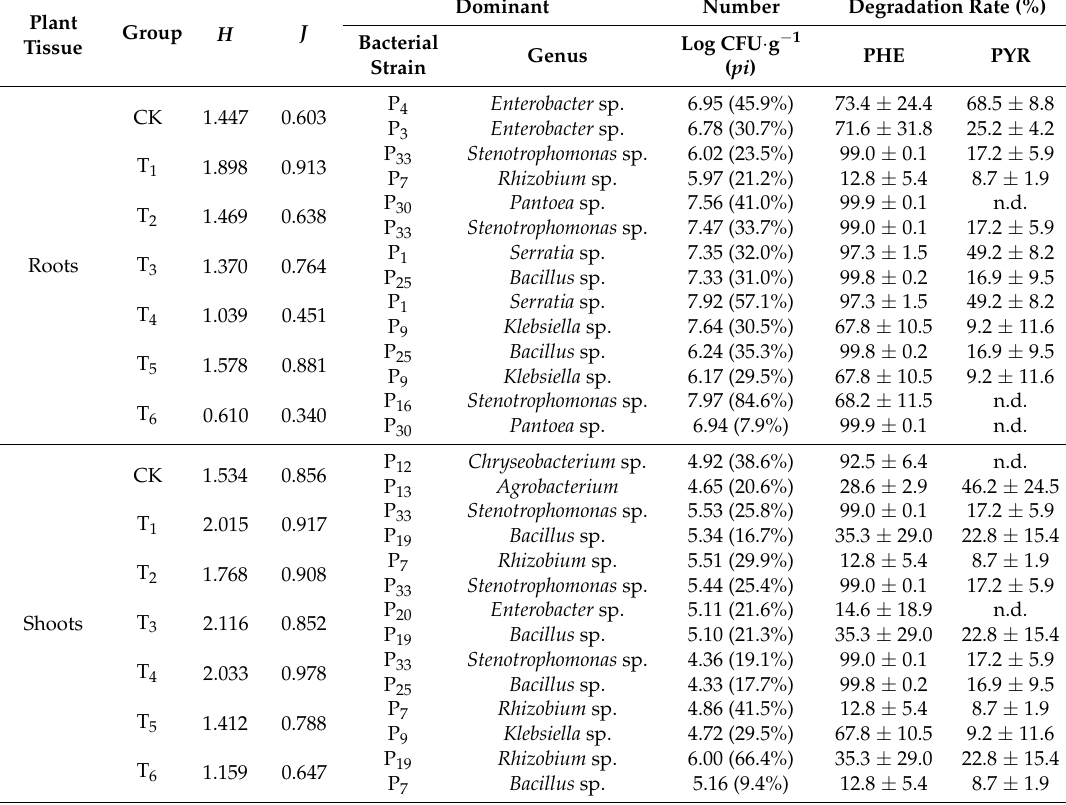
Table 4. Effect of PAHs on populations of endophytic bacteria inside